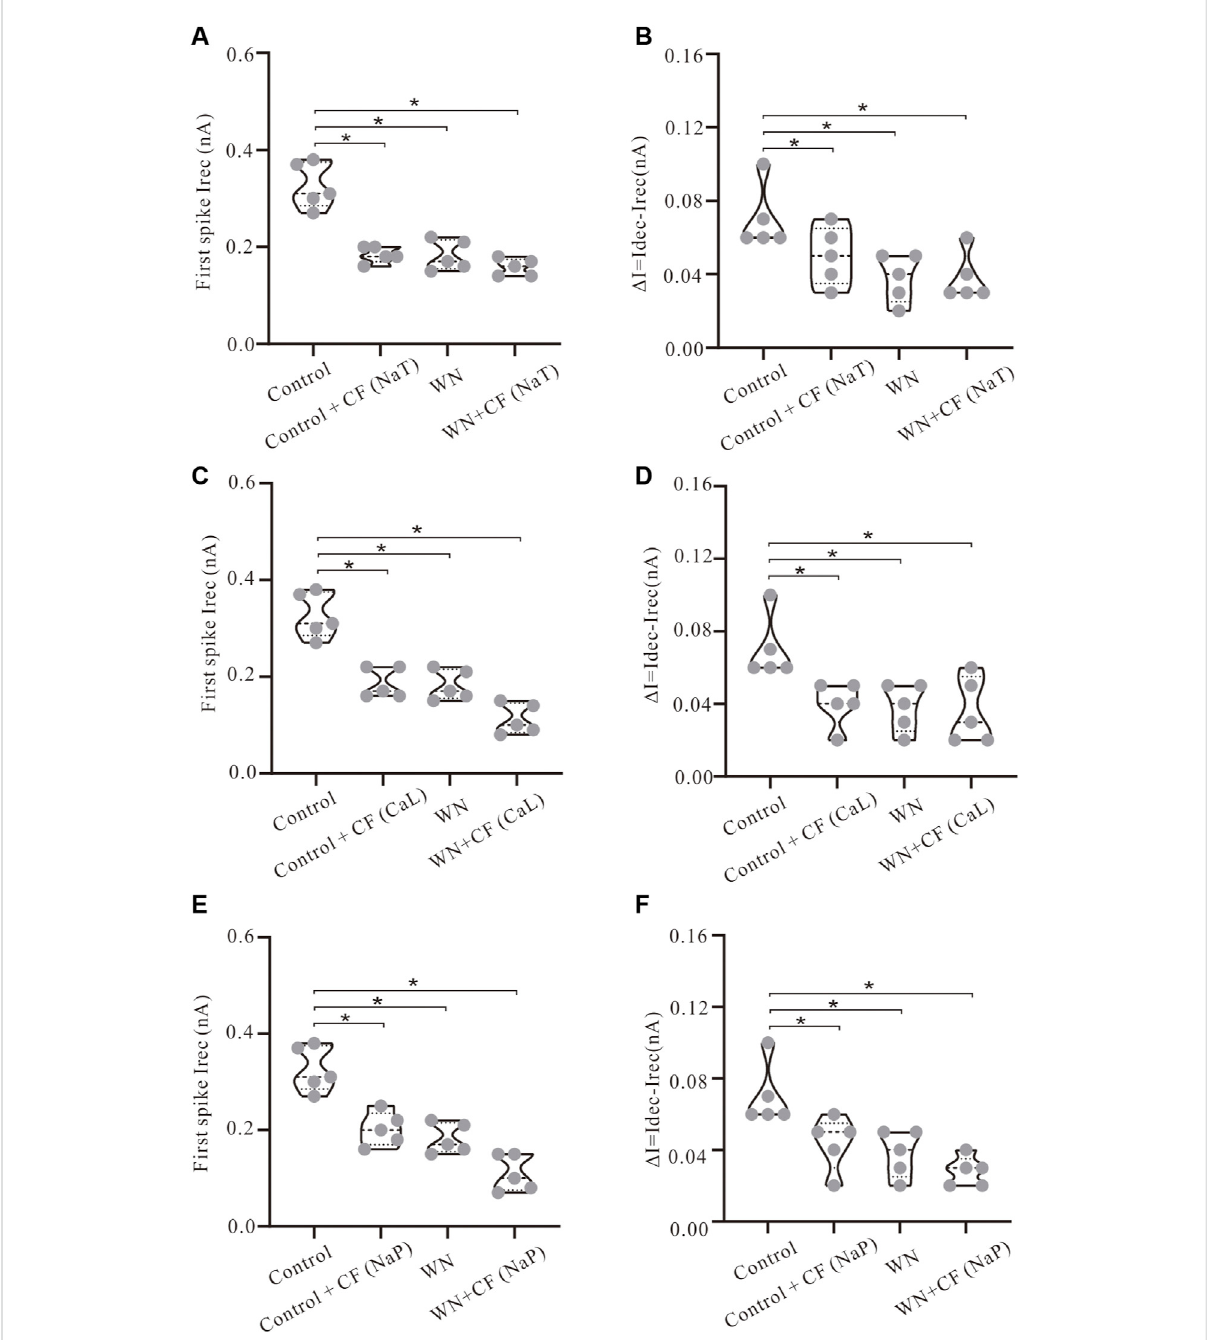
FIGURE 7 Effect of channel fl icker (CF) on recruitment and decruitment currents. The simulation data presented below were recorded with current ramp peak of 1 nA. (A) I rec was signi fi cantly reduced in Control + CF (NaT), WN and WN + CF (NaT). (B) Δ I was reduced signi fi cantly in Control + CF (NaT), WNandWN+CF(NaT). (C) I rec wassigni fi cantlyreducedinControl+CF(CaL),WNandWN+CF(CaL)andtheamountofreductionofI rec inducedby WN+CF(CaL)wasbiggerthanthatbyControl+CF(CaL)orWN. (D) Δ Iwasreducedsigni fi cantly inControl+CF(CaL), WNandWN+CF(CaL). (E) I rec was signi fi cantly reduced in Control + CF (NaP), WN and WN + CF (NaP), and the amount of I rec reduction induced by WN + CF (NaP) was bigger than that byControl + CF (NaP) or WN. (F) Δ I was reduced signi fi cantly in Control + CF (NaP), WN and WN+ CF(NaP). (G) I rec was signi fi cantly reduced in Control + CF (K(DR)), WN and WN + CF (K(DR)). The amount of reduction of I rec induced by WN + CF (K(DR)) was bigger than that by Control + CF (K(DR)) or WN. (H) Δ I was reduced signi fi cantly in Control + CF (K(DR)), WN and WN + CF (K(DR)). * p <